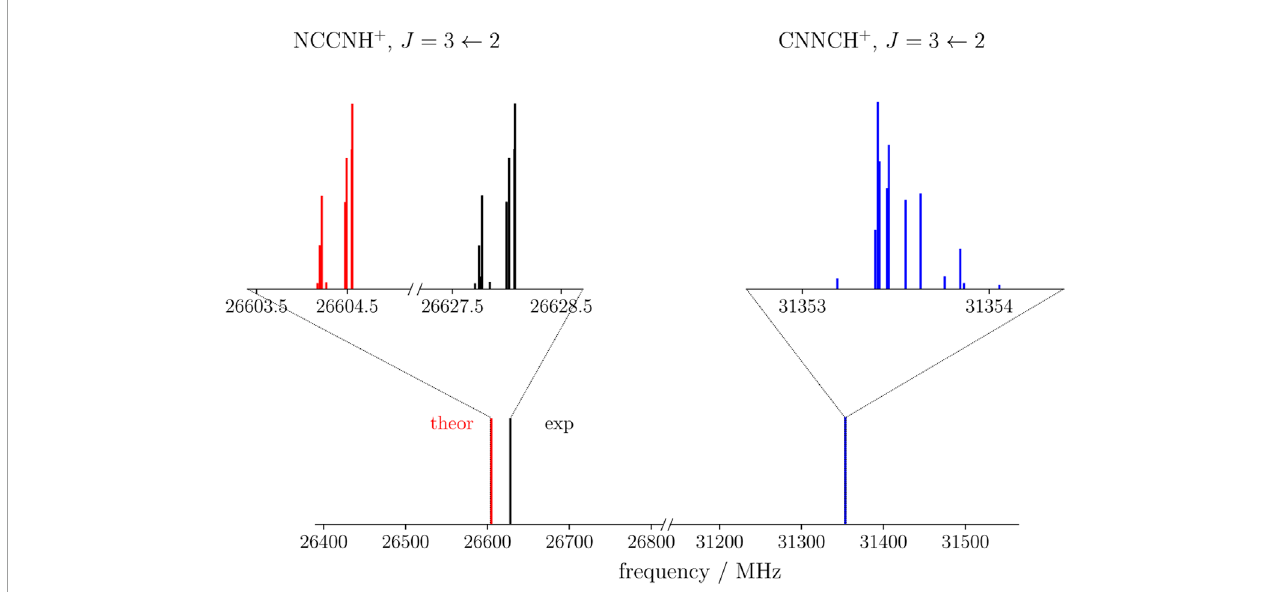
Frontiers in Astronomy and Space